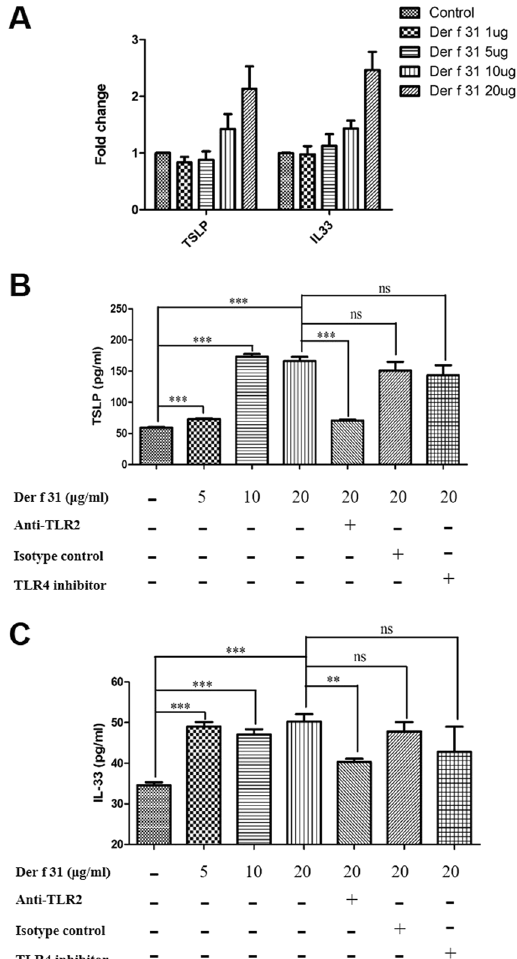
Figure 3. Der f 31 up-regulates the expression levels of TSLP and IL-33 in epithelial cells via TLR2. A549 cells were seeded into 6-well plates overnight and treated with different concentrations of Der f 31. At 4 hours, total RNA was extracted to analyze the expression levels of TSLP and IL-33 by RT-PCR. ( A ) The results of RT- PCR. The lung tissues from normal BALB/c mice were digested, and the cells were incubated with anti-TLR2 antibody, IgG1, κ isotype control (IC) or TLR4 inhibitor for 2 hours or 6 hours and then treated with Der f 31. At 96 hours, the supernatants were collected to perform ELISA. ( B ) The expression levels of TSLP. ( C ) The expression levels of IL-33. These data (means ± SEMs) were generated from three independent experiments and processed with GraphPad software. The significant differences between two groups were tested by two-tailed T-test. ** p < 0.01. *** p < 0.001. ns, no significant